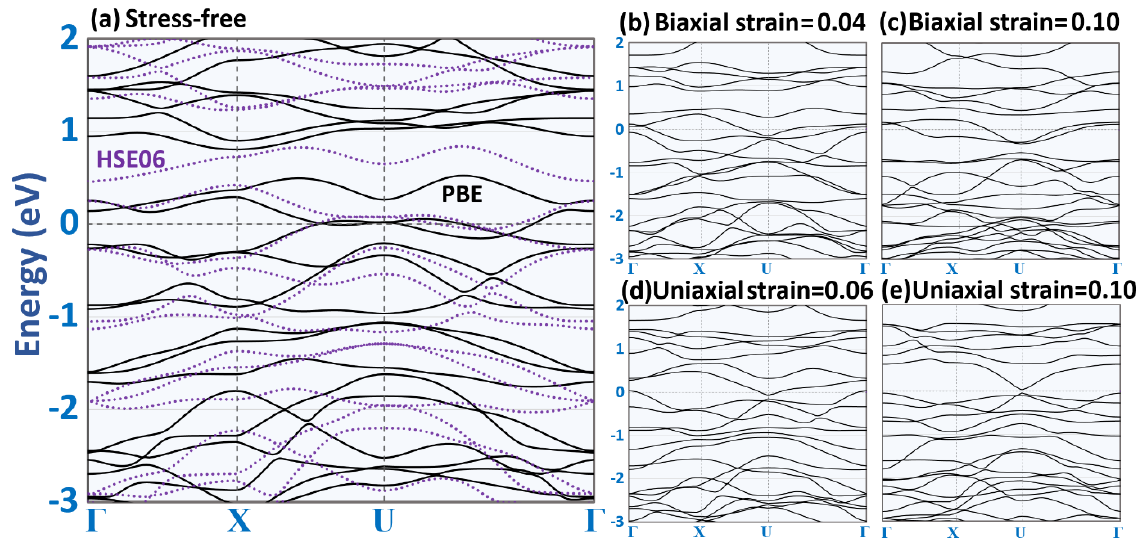
Figure 3. Electronic band structures of the stress-free and strained B 40 2D network by the PBE (solid lines) and HSE06 (dotted lines) methods.